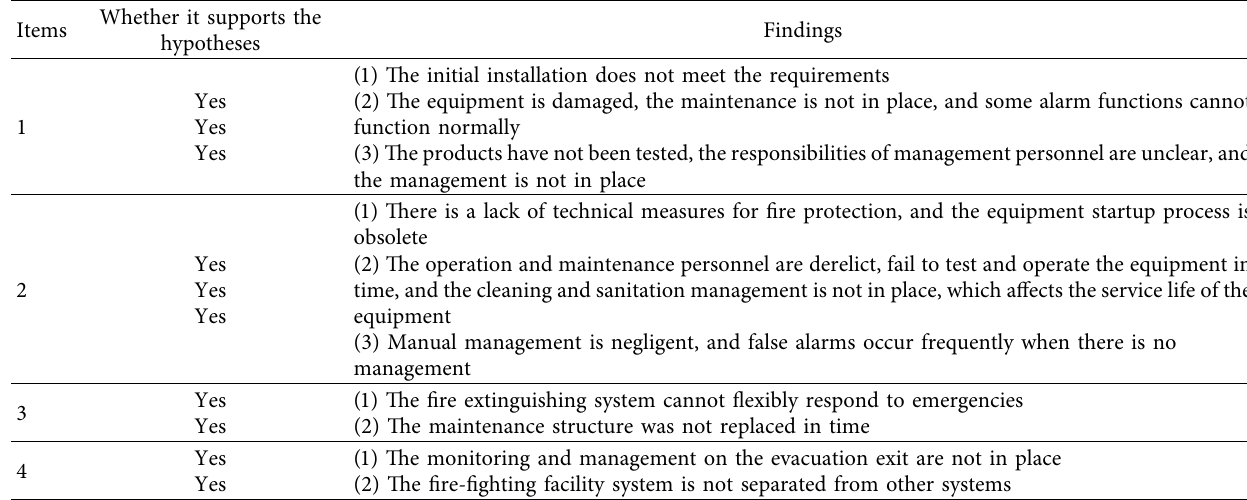
Table 11: Te conclusion of summarized fndings.